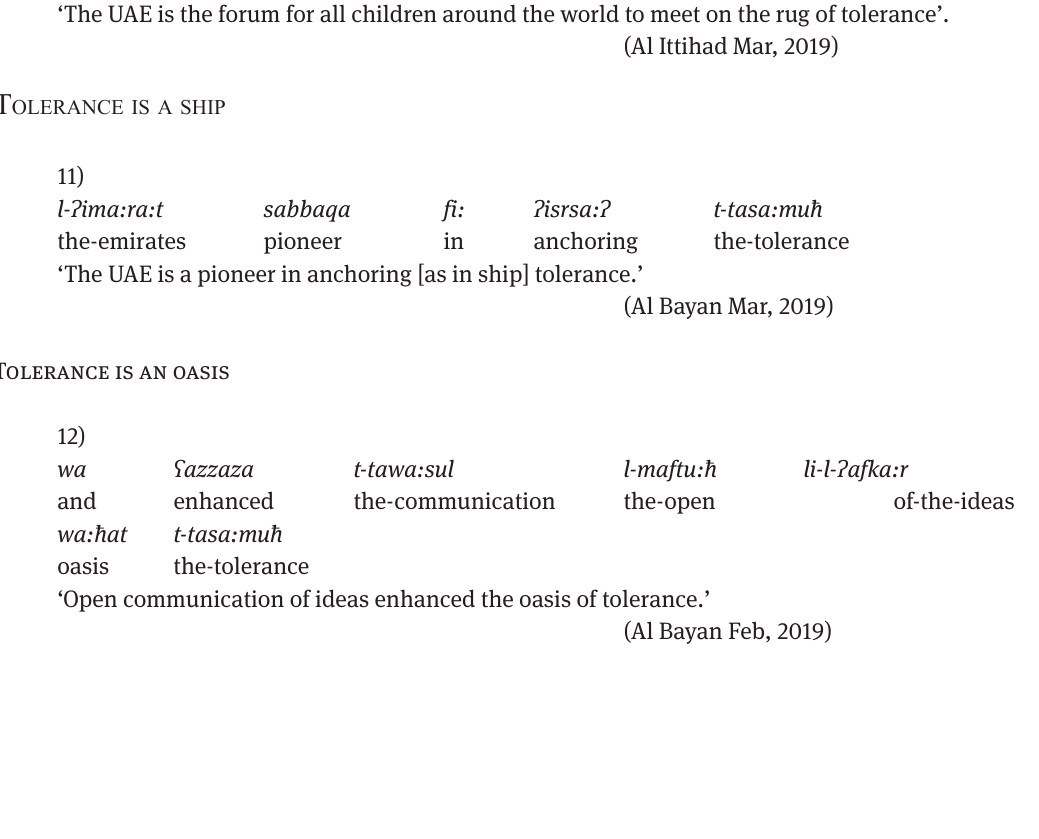
the-determination on rug the-tolerance